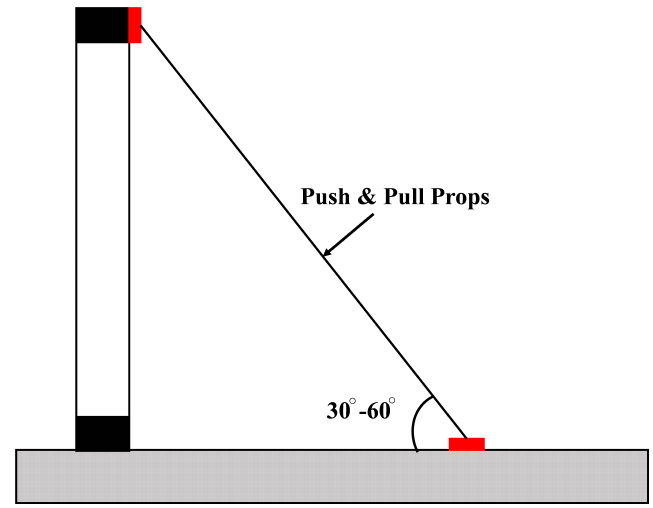
Figure 11. Propping method of masonry walls.